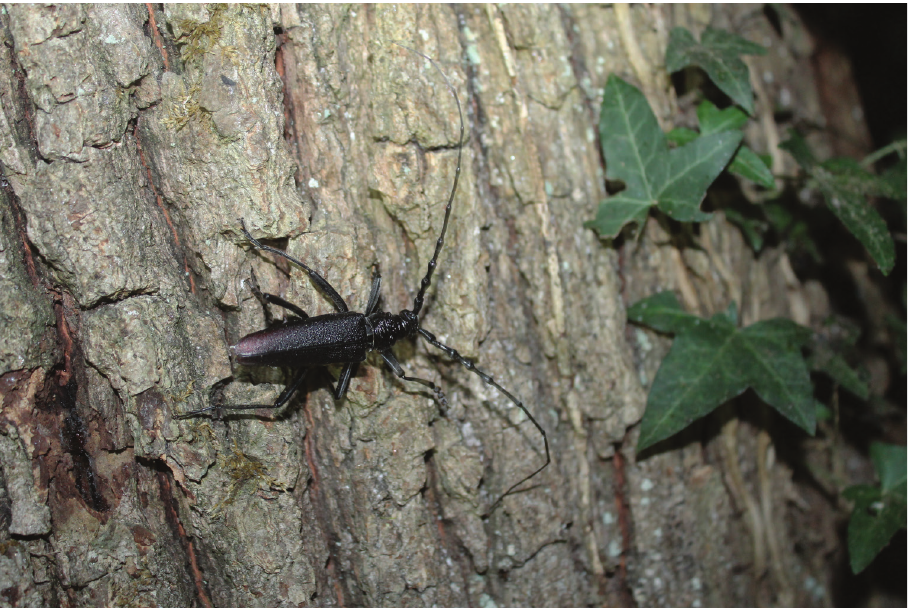
Figure 5. An individual of Cerambyx cerdo observed on tree selected for the VES (Visual Encounter Surveys) (Photo by S.G.